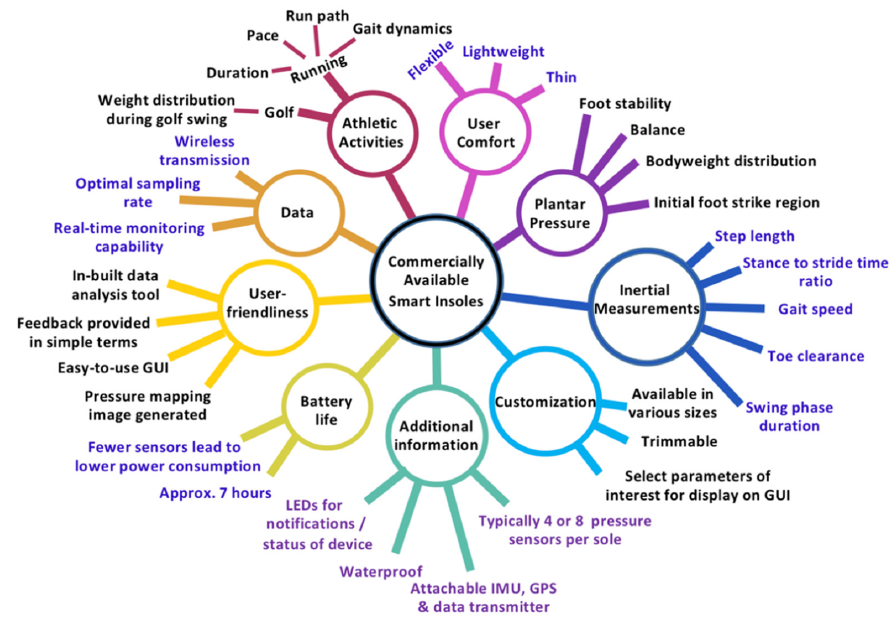
Figure 6. Characteristics of several existing commercial “smart insole” pressure measurement systems.